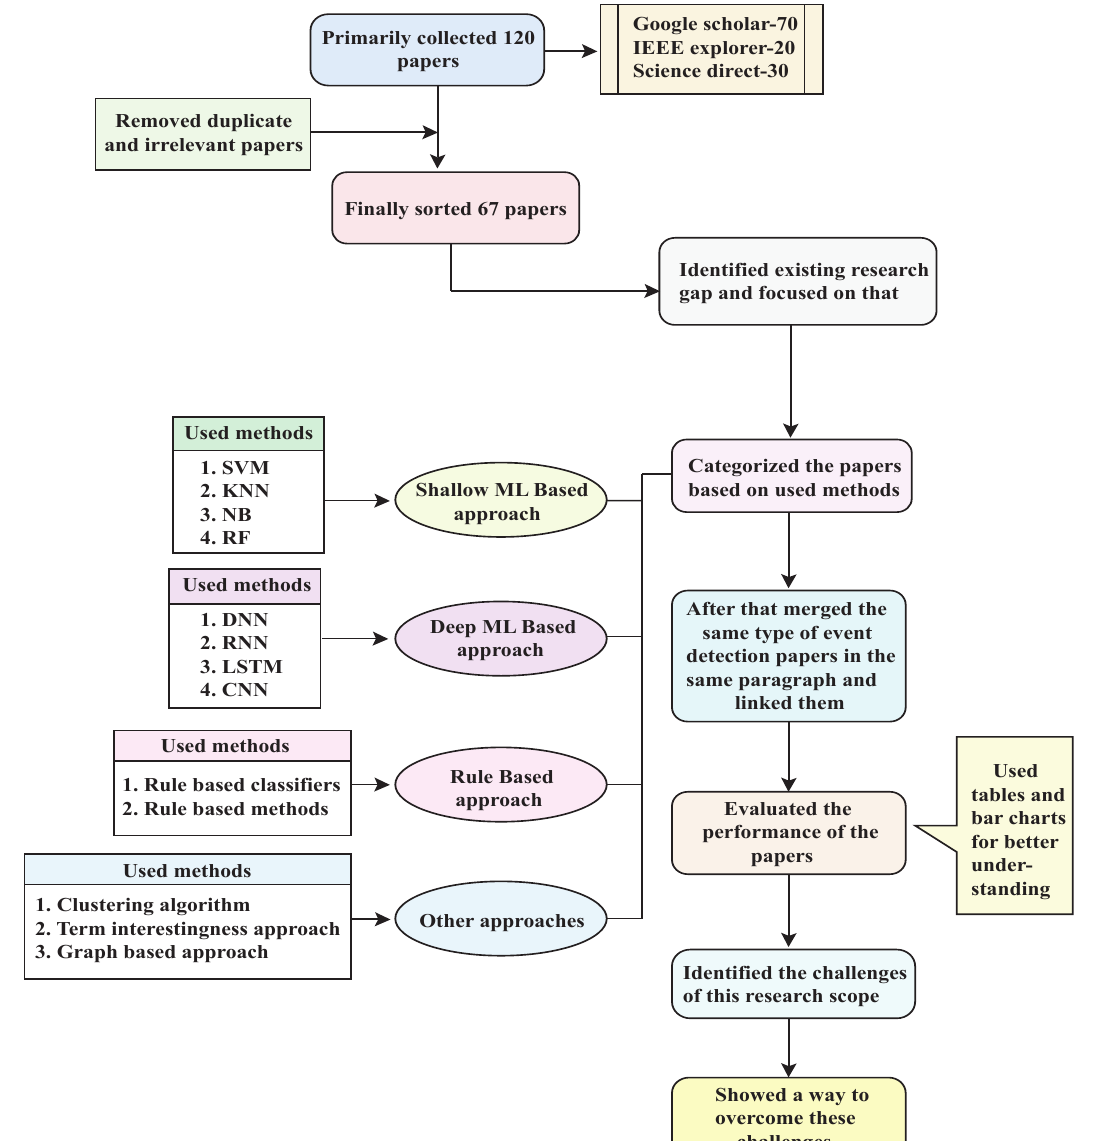
Figure 3. A flowchart visualizing every stage of our research survey from the beginning until the